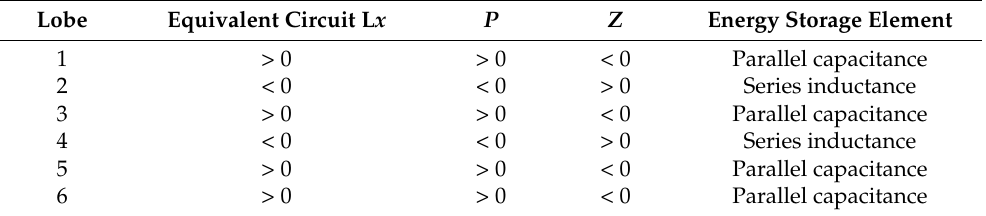
Table 2. Properties of locally active